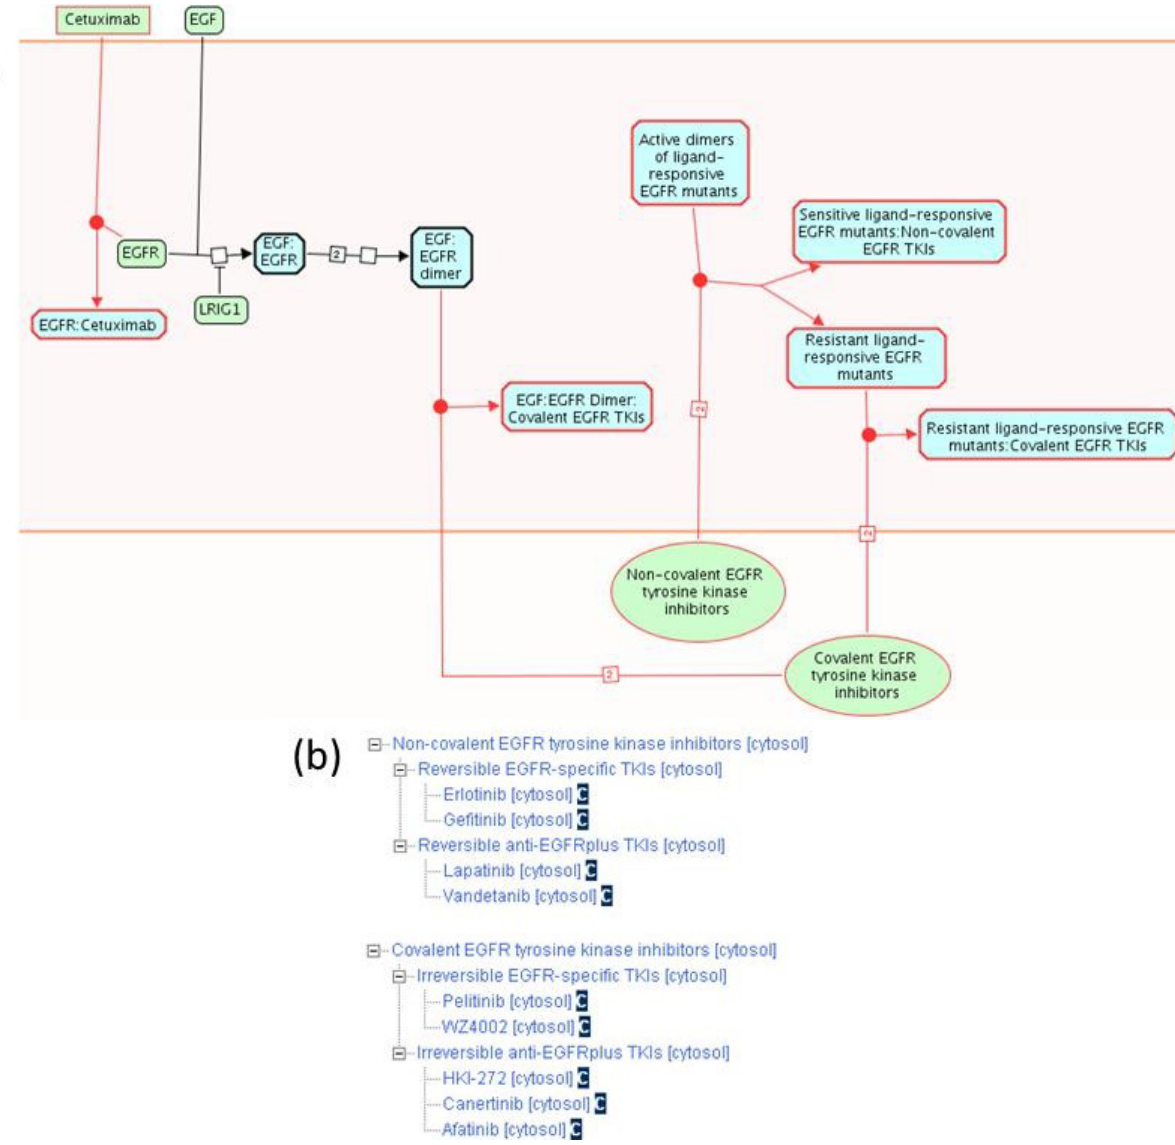
Figure 3. Mode of action and specificity of anti-EGFR cancer therapeutics. ( a ) Anti-EGFR therapeutics differ in their specificity for EGFR cancer variants, as well as in their mode of action (non-covalent vs . covalent binding). ( b ) Classification of EGFR-binding small tyrosine kinase inhibitors (TKIs) according to spectrum and reversibility of their